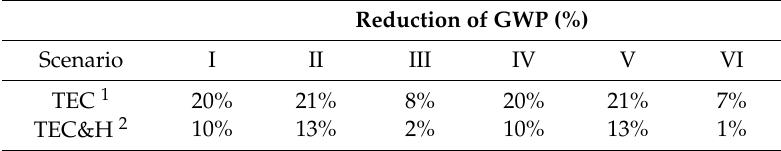
Table 9. GWP results reduction by prolongation of expected lifetime to 20 years,